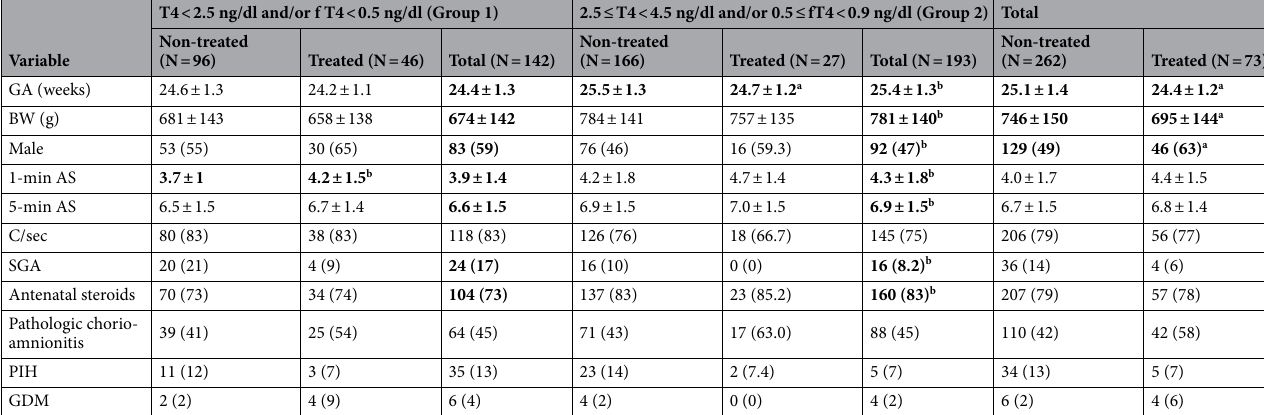
Table 1. Demographic characteristics of the infants with transient hypothyroxinemia of prematurity. Values are presented as means ± SD or n (%). Significant values are in [bold]. T4 thyroxine, fT4 free thyroxine, GA gestational age, BW birth weight, AS Apgar score, SGA small for gestational age, PIH pregnancy-induced hypertension, GDM Gestational diabetes mellitus. a p < 0.05 compared with non-tereated group. b p < 0.05 compared with group 1.